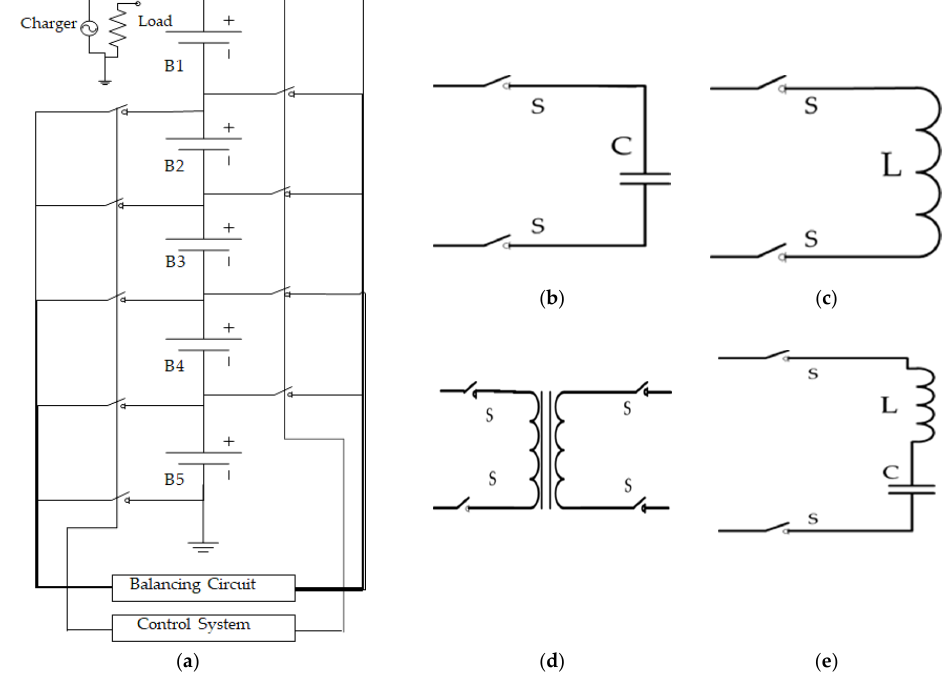
Figure 2. Direct C2C balancing system ( a ) basic circuit structure, ( b ) single capacitor-based direct C2C, ( c ) single indictor-based direct C2C, ( d ) single transformer-based C2C, and ( e ) single resonant-converter-based